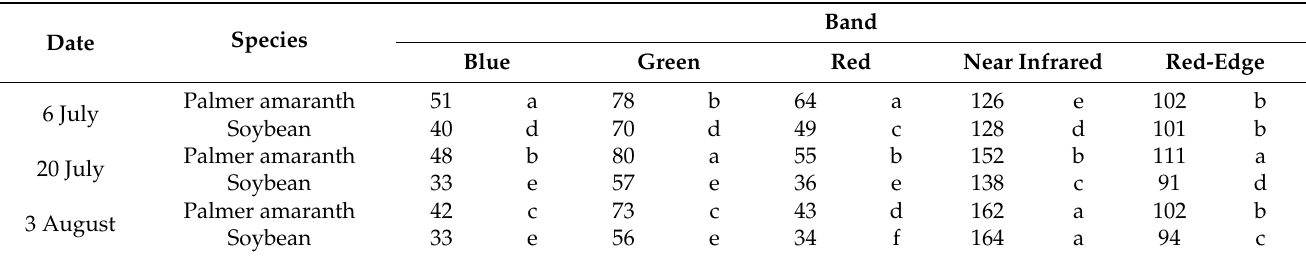
Table 5. Spectral reflectance values of Palmer amaranth and soybean across dates from aerial imagery collected from an altitude of 15 m at Rocky Mount, NC in 2017 (B8).